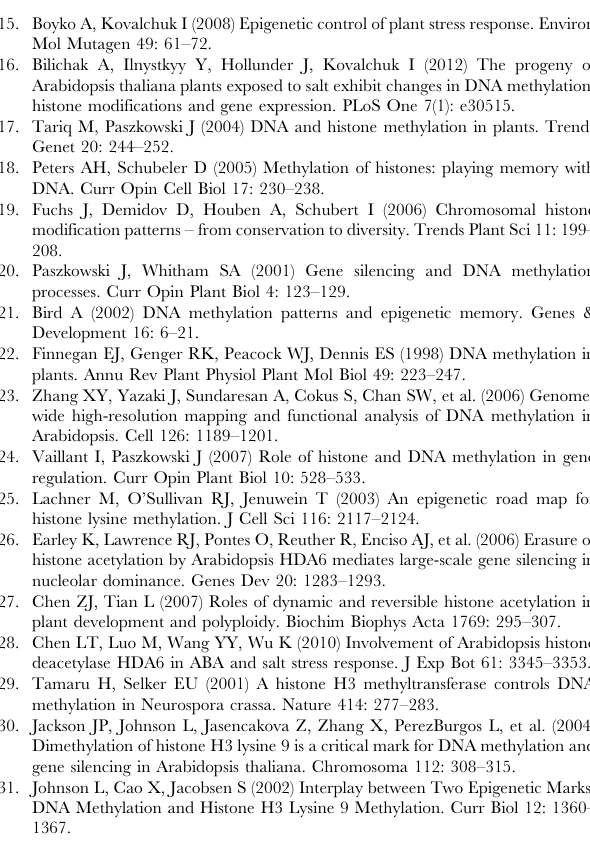
plasmid was treated with bisulfite. Nine positive clones of this gene from the bisulfite treated DNA were sequenced and compared with the untreated DNA sequence. Figure S2 Genomic bisulphite sequencing of six un- methylated genes in plants not exposed to salinity (S0) and those stressed for 1–24 h (S1–S24). Ten clones of each gene were sequenced. The short thick bars indicate the regions subjected to sequencing, and the long vertical ones show the distribution of CG dinucleotides (black circles), and CNG (triangles) and CNN (unmarked) trinucleotides. The black vertical line represents the proportion of methylated sites. Data represent the mean of three biological replicates.